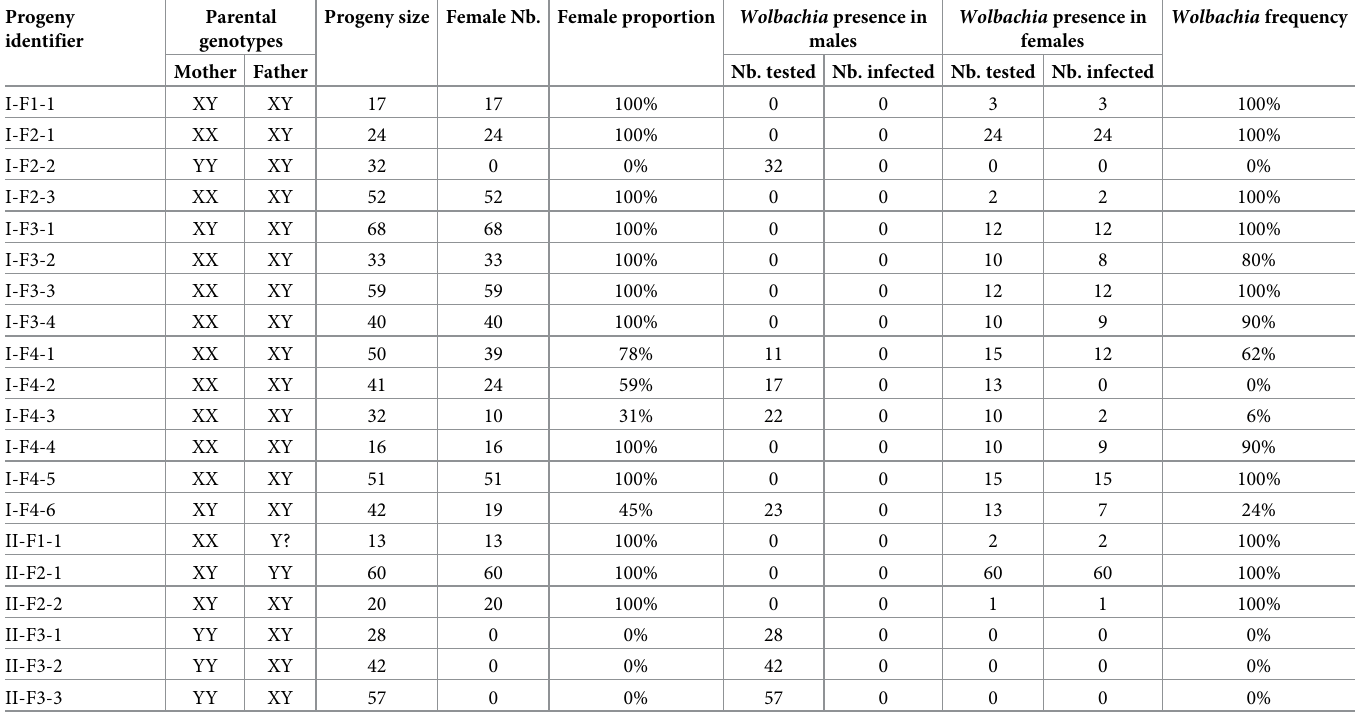
Table 2. Composition and frequency of Wolbachia infection in 20 families of A . nasatum . Wolbachia frequency in progenies was calculated as the Wolbachia fre- quency observed among tested females weighted by female proportion in the progenies (as all males lack Wolbachia ). Progeny